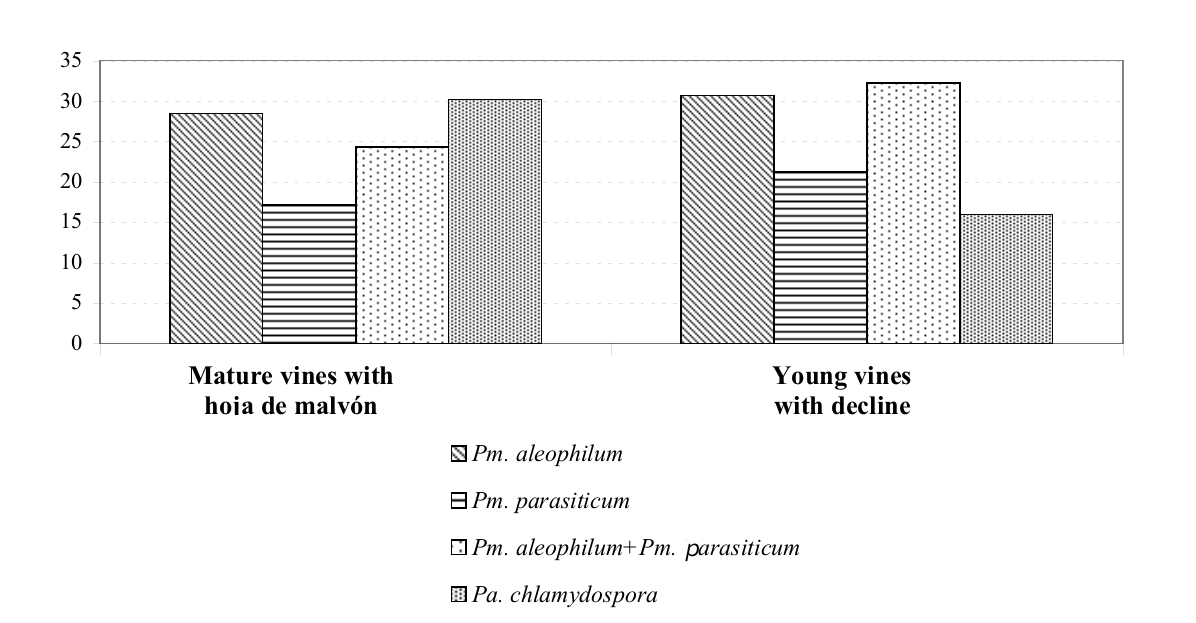
Fig. 3. Percent incidence of Phaeoacremonium species and Phaeomoniella chlamydospora isolated from mature and young